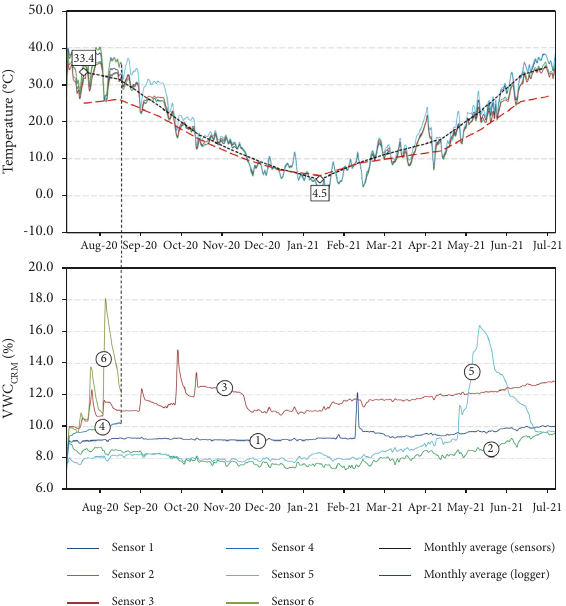
Figure 15: Moisture and temperature variation during the first